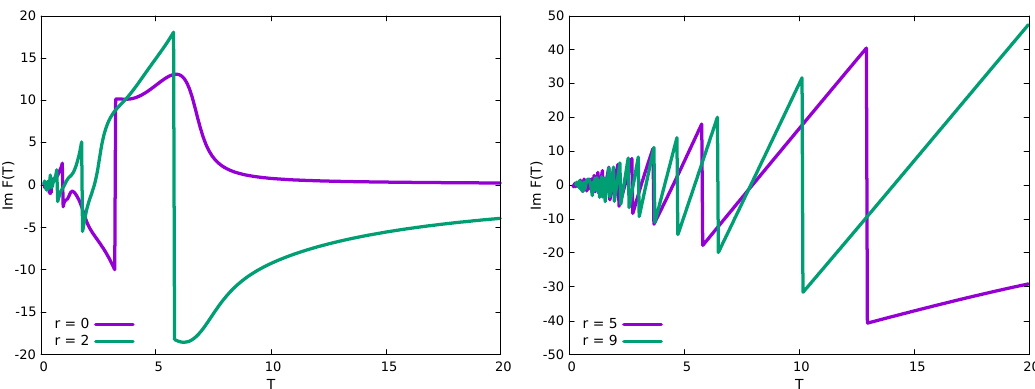
Figure 11: Imaginary part of the free energy for z = re i π/ 6 , N = 34 and different r ’s. As r increases, the free energy develops a characteristic saw-like shape.